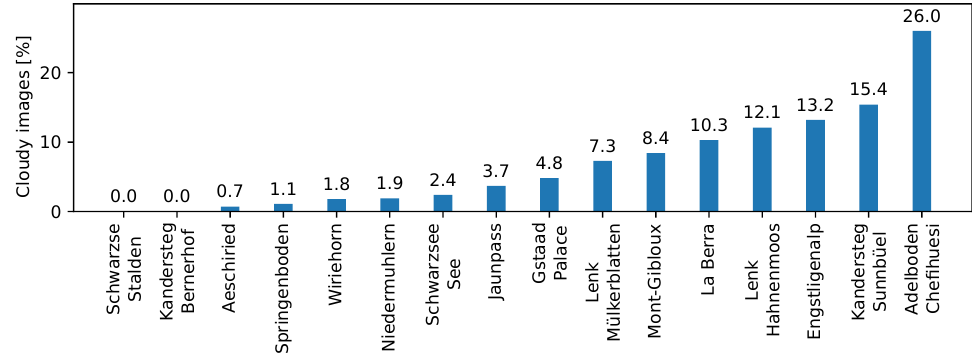
Figure 6. Percentage of cloudy images of the selected webcams during the investigated time period between October 2017 and end of June 2018.